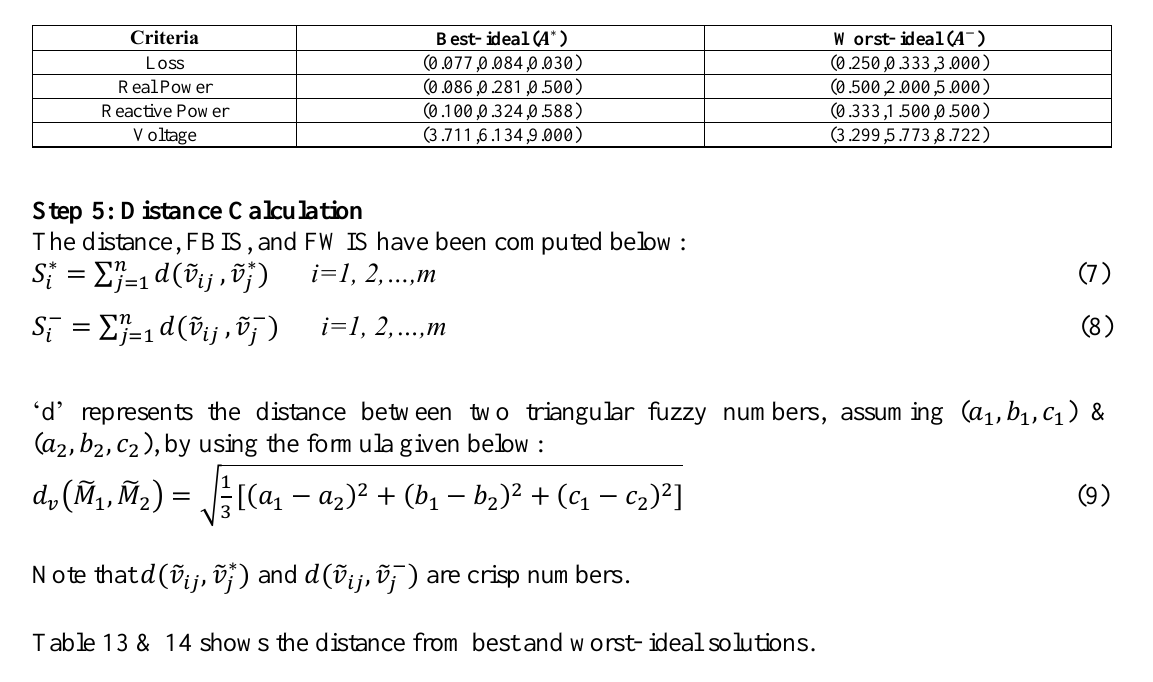
Table 12. Best and worst-ideal solutions.